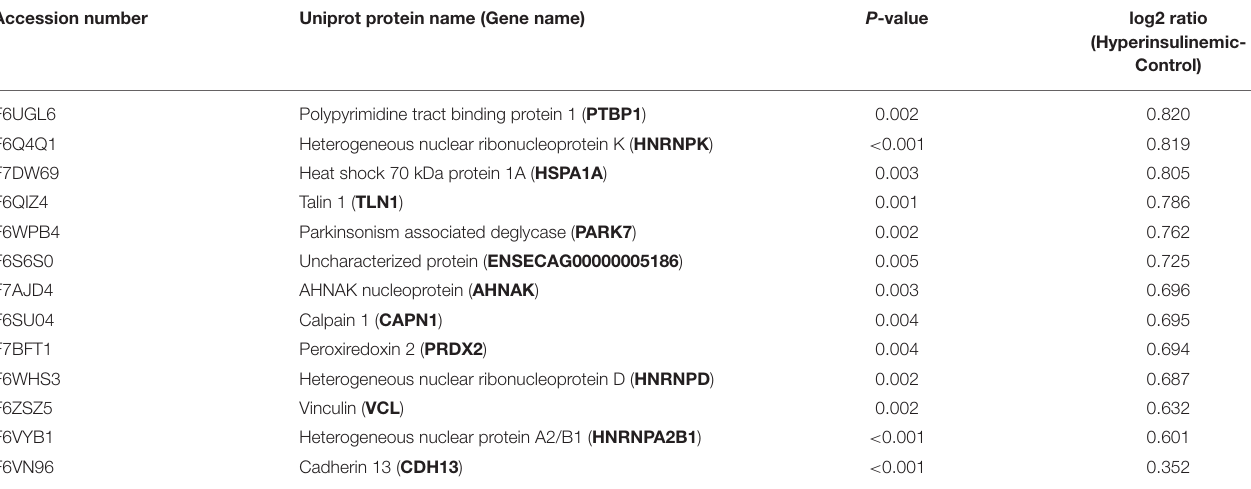
TABLE 2 | Proteins significantly decreased in lamellar tissue of hyperinsulinemic